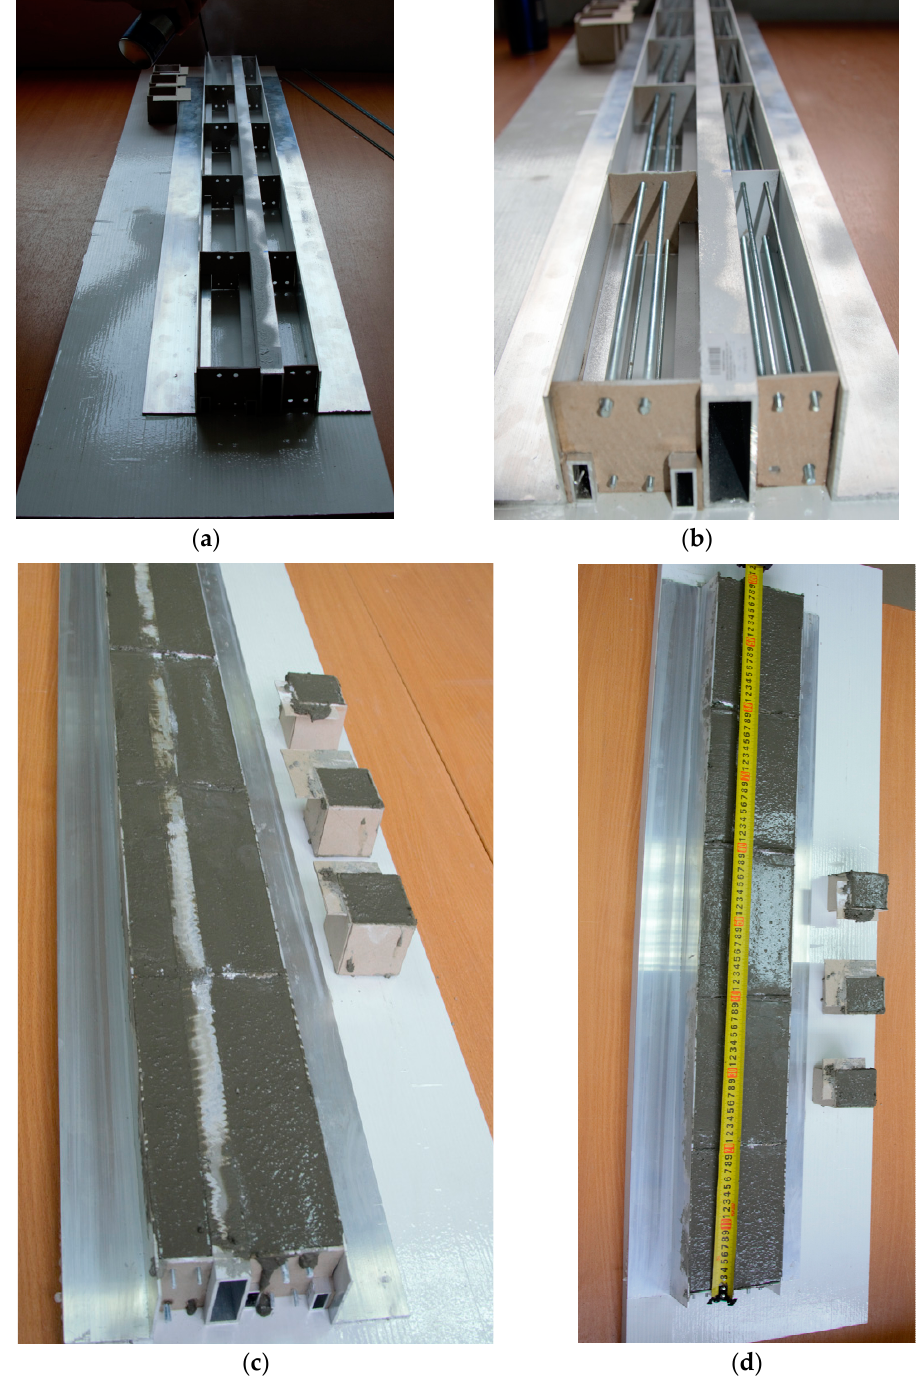
Figure 8. Formwork and reinforcement work and concreting of beams: ( a )—formwork coating with Teflon grease, ( b )—location of reinforcement in beams, ( c )—concreting of beams and cubes, ( d )—dimensions of the test samples.